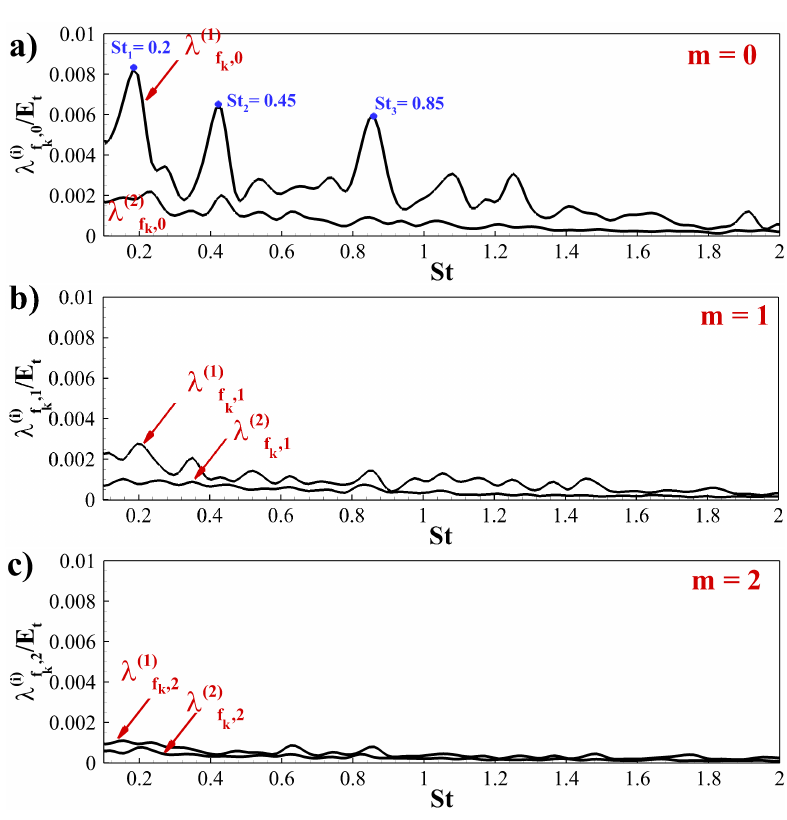
Figure 8. SPOD eigenvalues normalised by total flow energy as a function of Strouhal number for the first and second SPOD modes of azimuthal mode numbers of ( a ) m = 0 (axisymmetric); ( b ) m = 1 (helical); and ( c ) m =